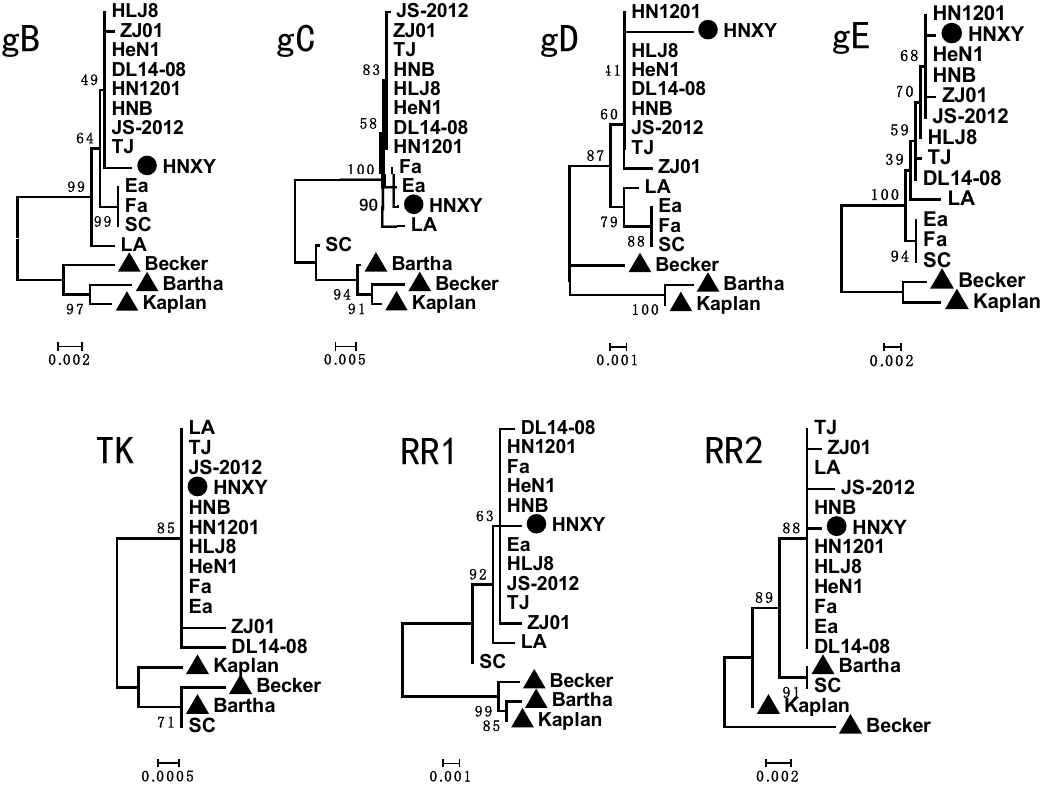
Figure 3. Phylogenetic trees based on gB, gC, gD, gE, TK, RR1 and RR2 genes, respectively. “ ● ” is HNXY,the PRV isolates from Henan, “ ▲ ” is the PRV isolates from other countries.